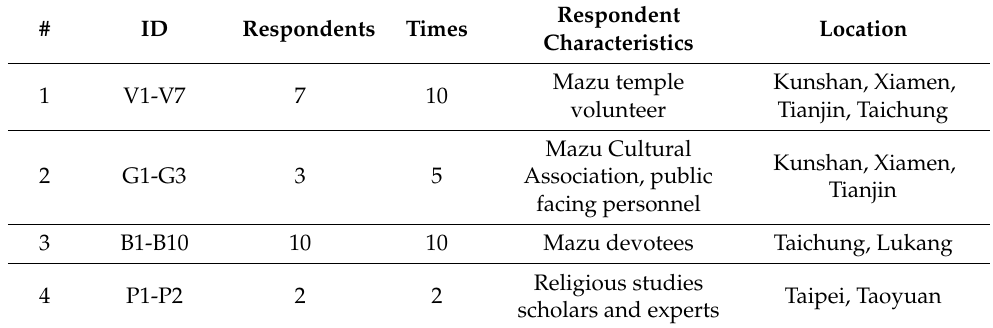
Table 1. Interviewee